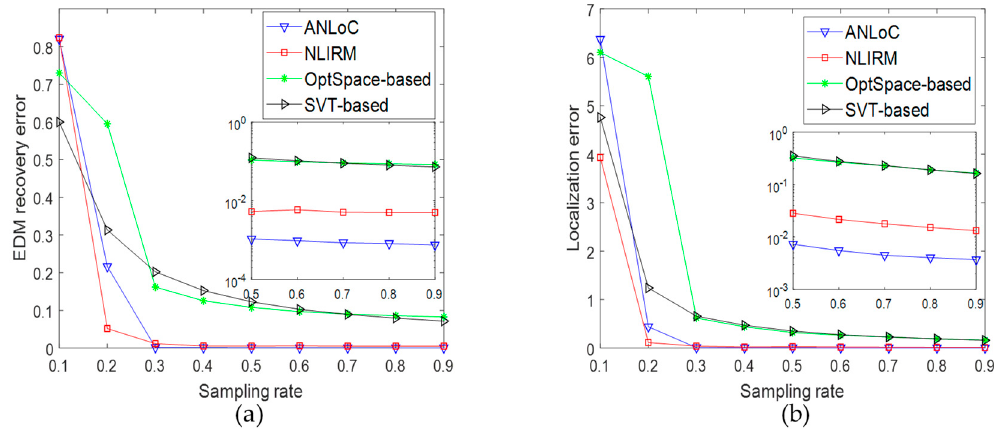
Figure 4. Performance comparison under scenario 2 with only complex noise. ( a ) EDM recovery error and ( b ) localization error.